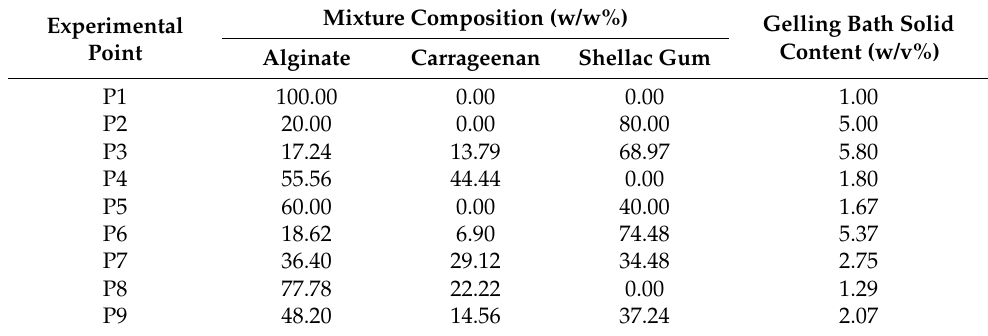
Table 1. Composition of mixture design experimental points and solid content of each gelling bath. Mixture Composition (w/w%) Gelling Bath Experimental Point